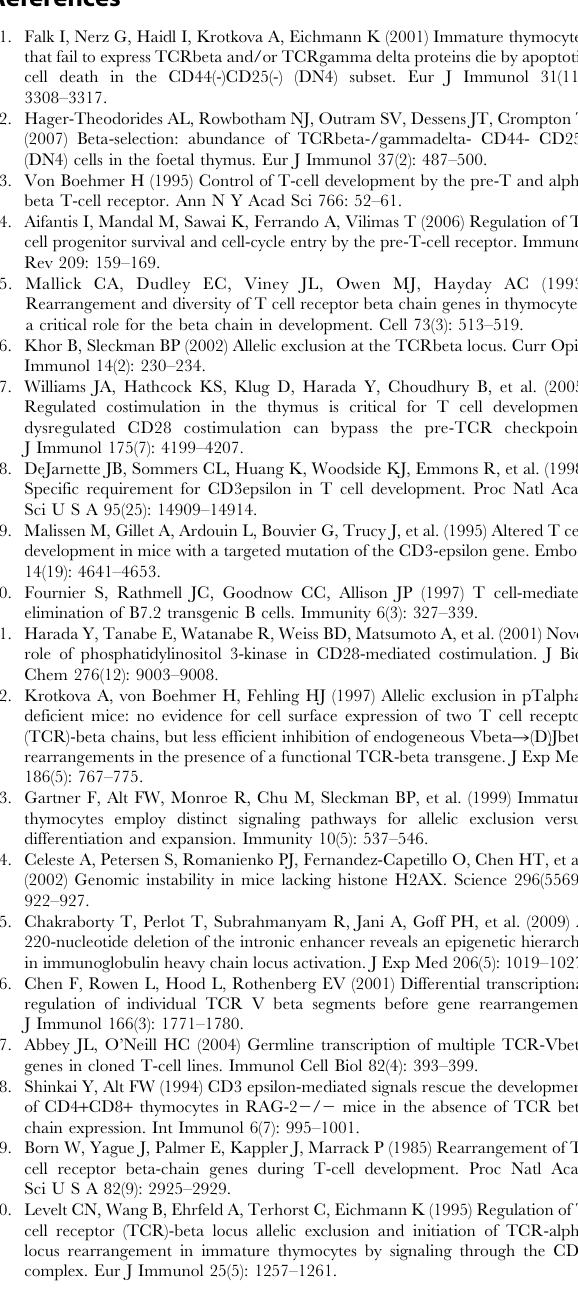
Table S3 PCR primers used to detect germline tran- scription of unrearranged TCR b